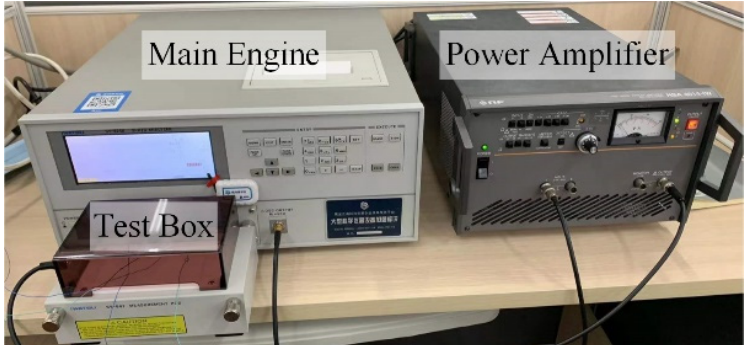
Figure 2. Experimental setup test.